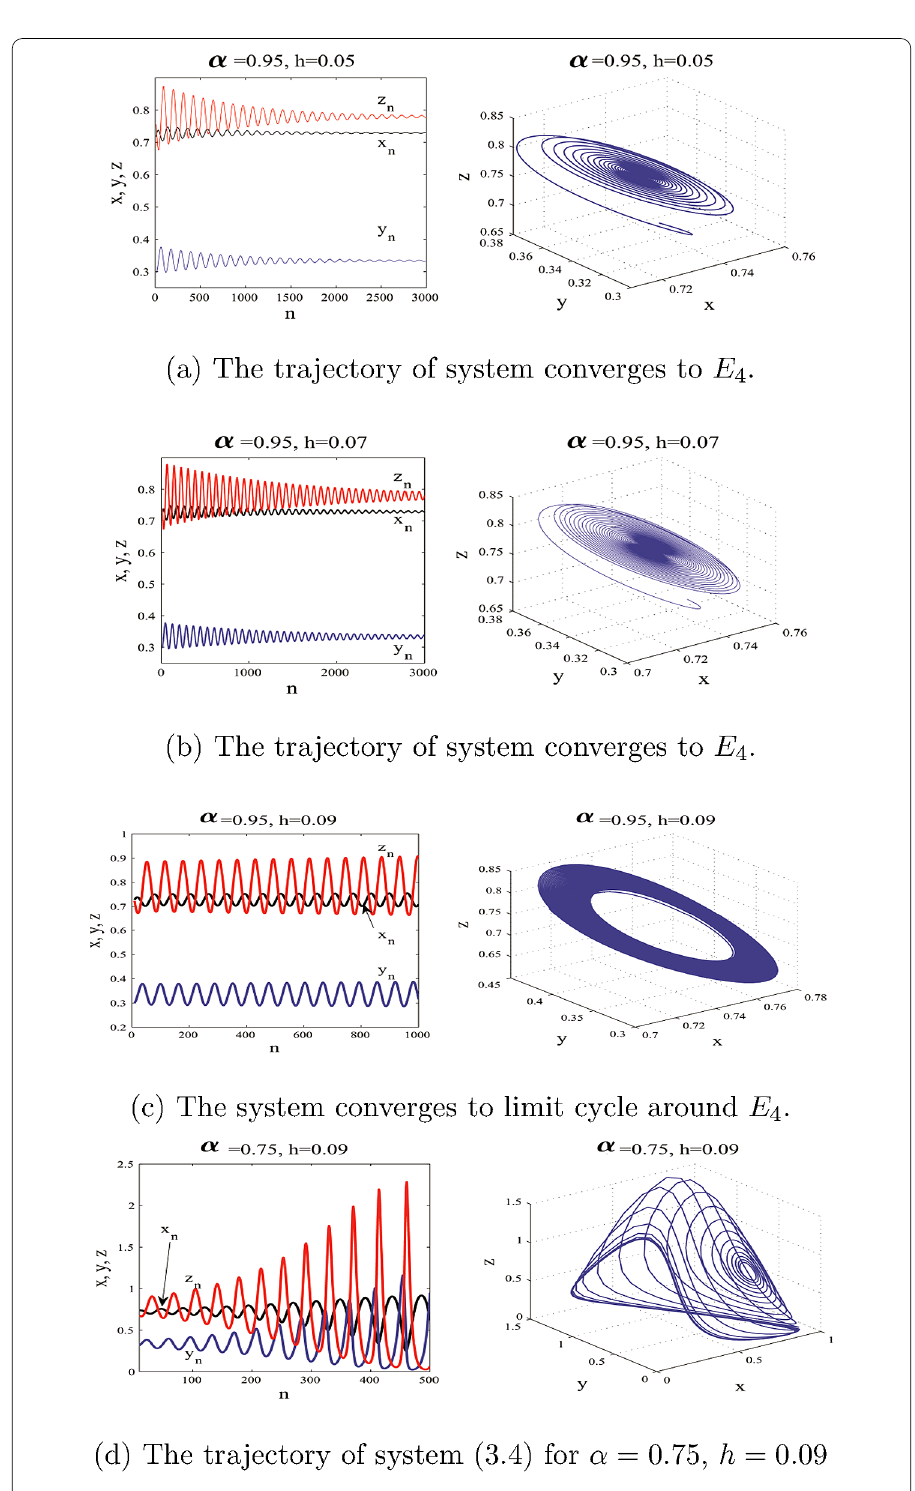
Figure 1 Phase portraits of model